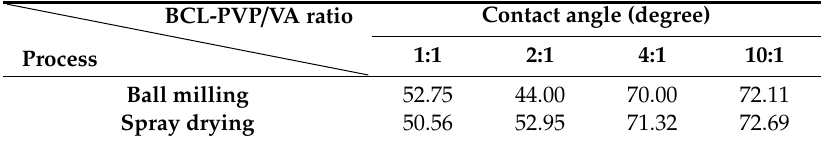
Table 5. The values of contact angle of solid dispersions obtained using the sessile drop technique.